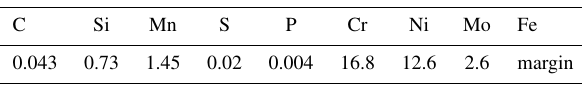
Table 1. Composition of 316L stainless steel powder